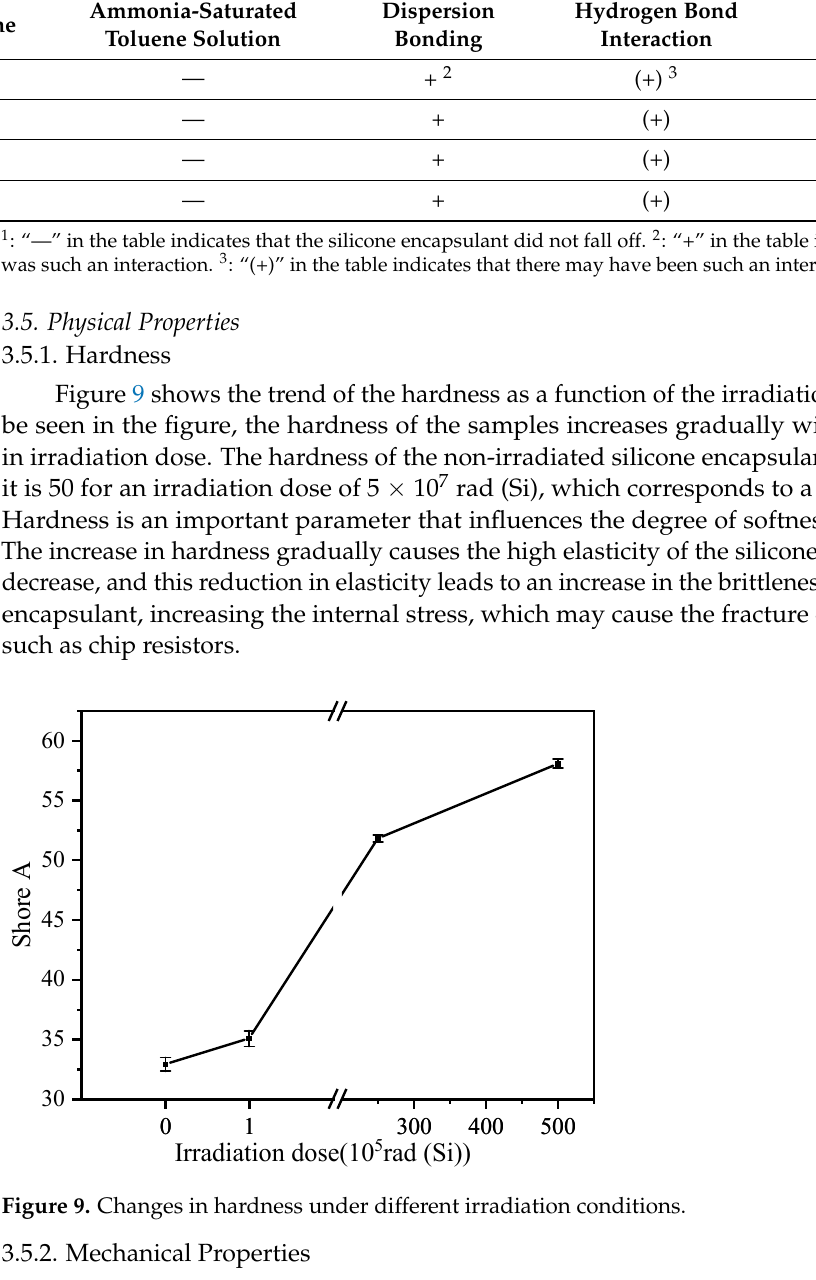
Irradiation Dose